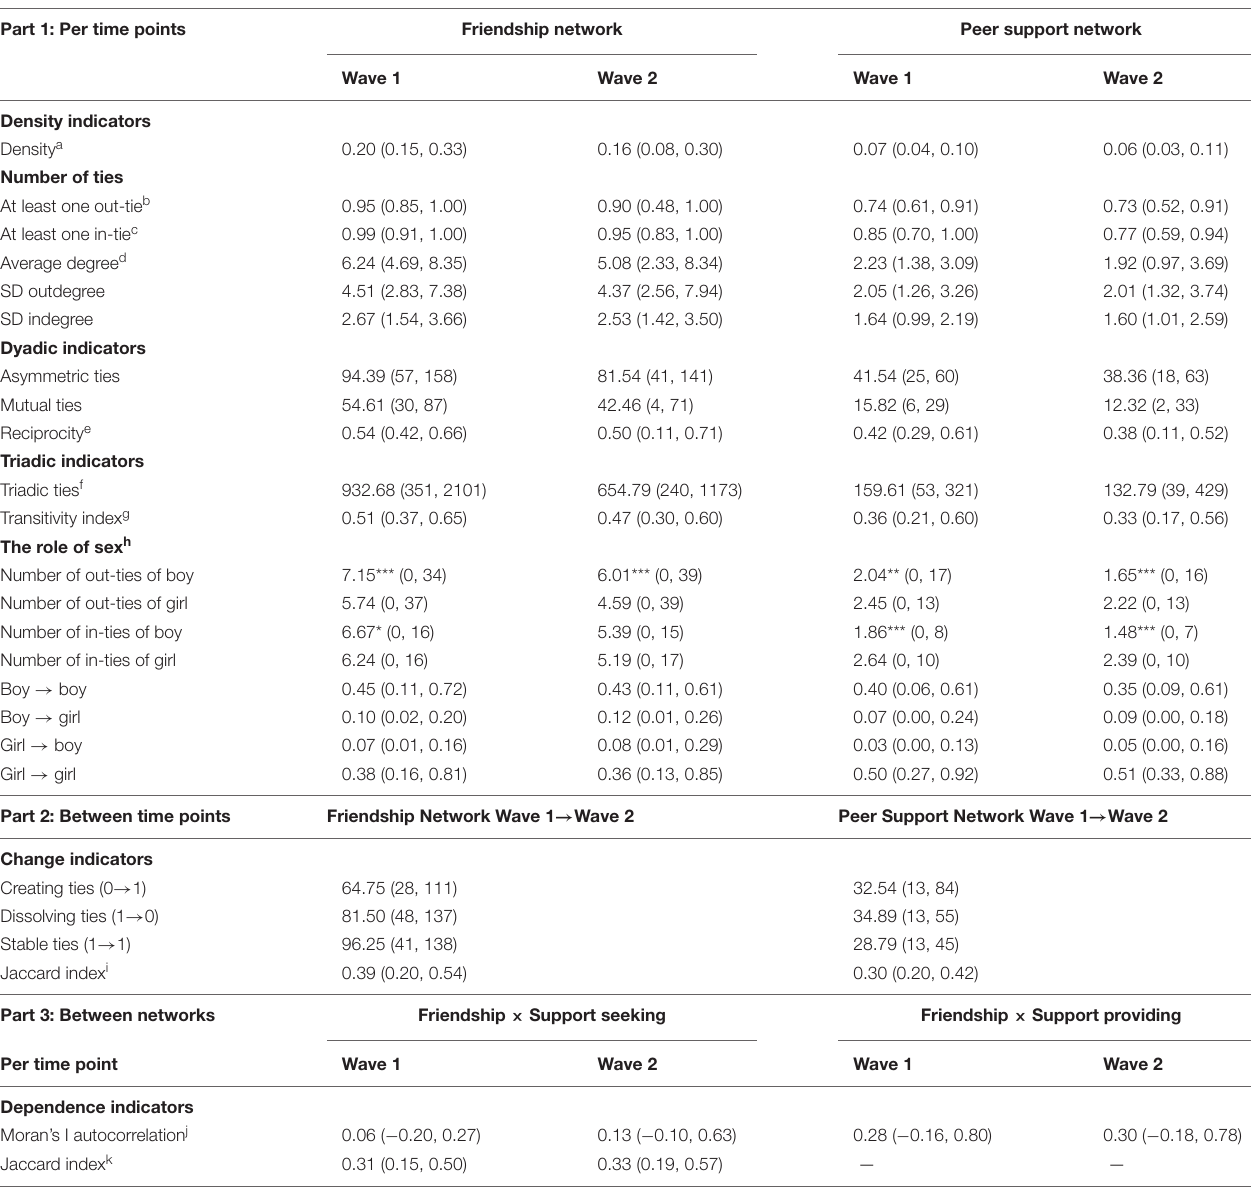
TABLE 2 | Descriptive statistics of friendship networks and peer support